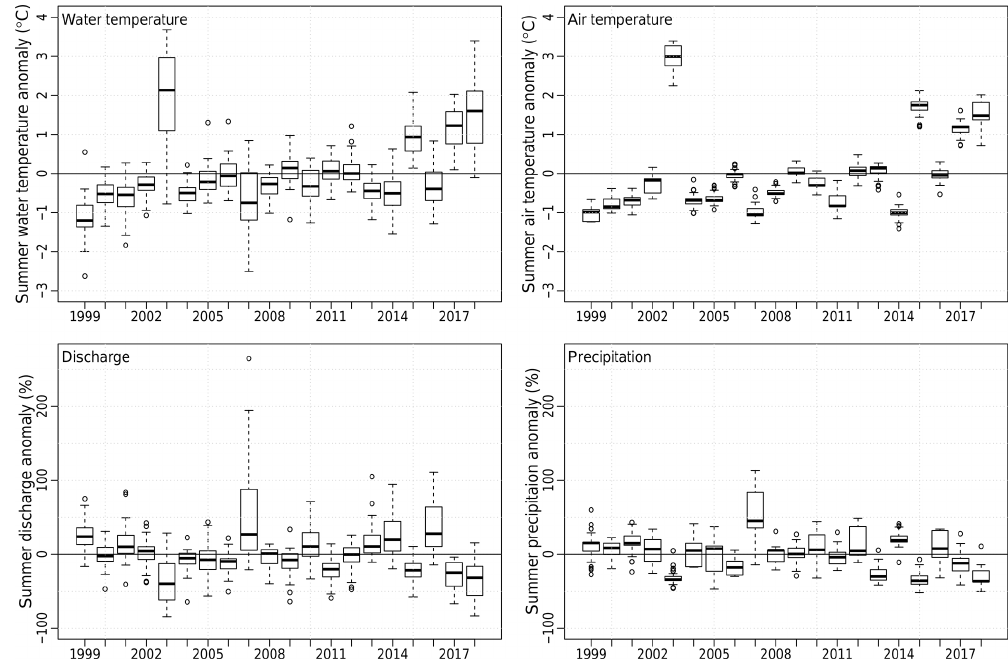
Figure 11. Summer anomalies in water temperature, air temperature, relative discharge, and relative precipitation for all 52 catchments. Anomalies are computed with respect to the 1999–2018 mean for each